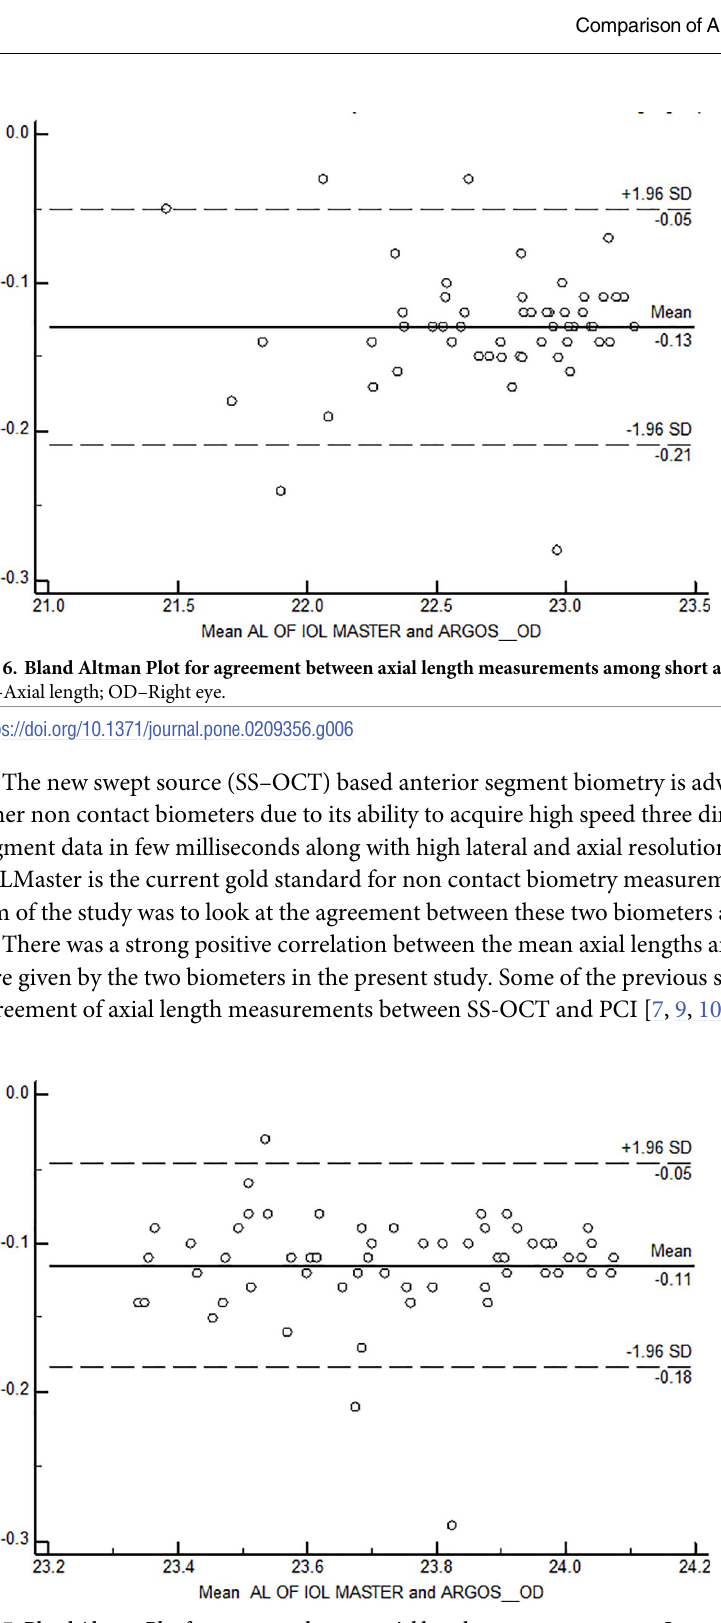
Fig 7. Bland Altman Plot for agreement between axial length measurements among Intermediate axial length group. AL-Axial length; OD–Right